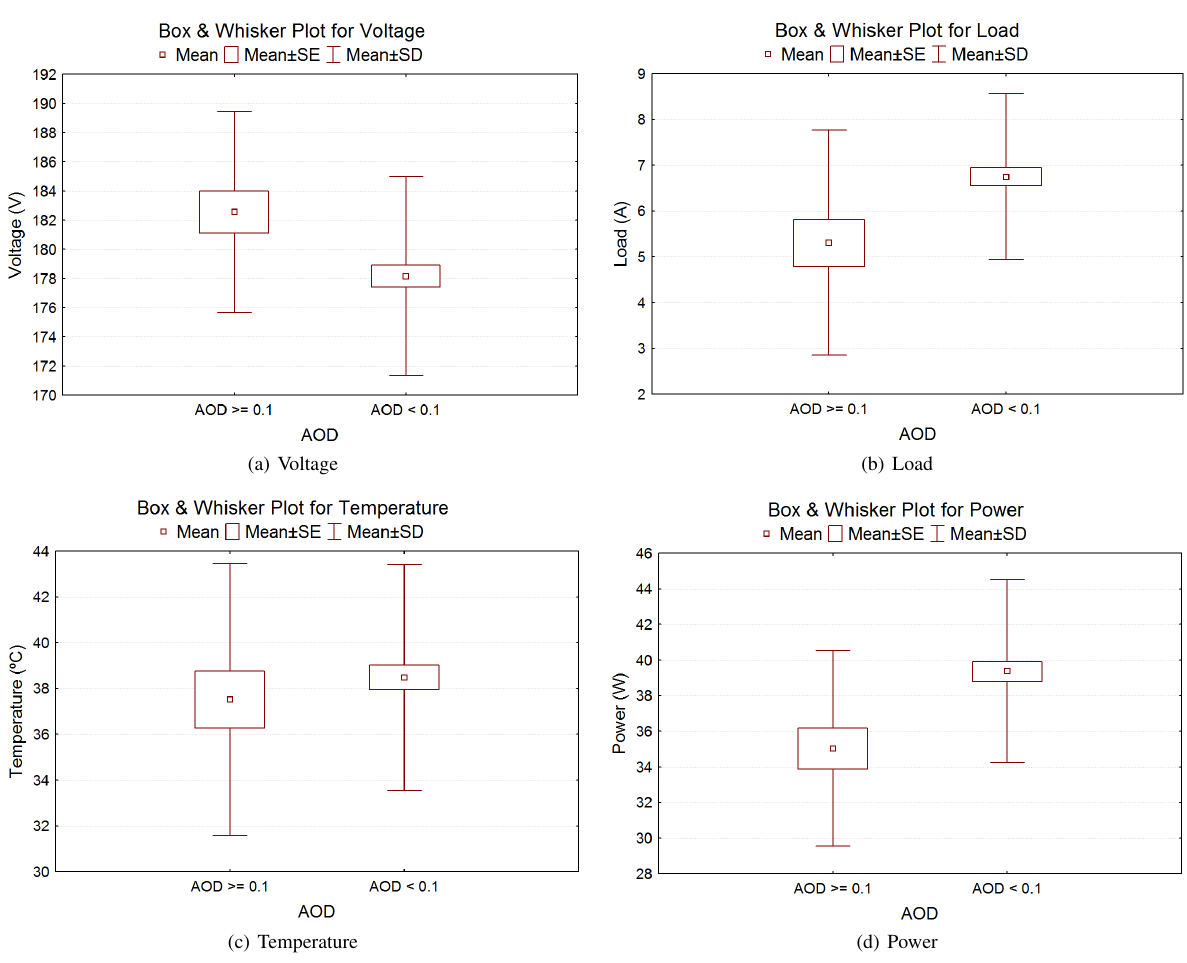
Figure 6. Box & whisker plot of power generation indicators and